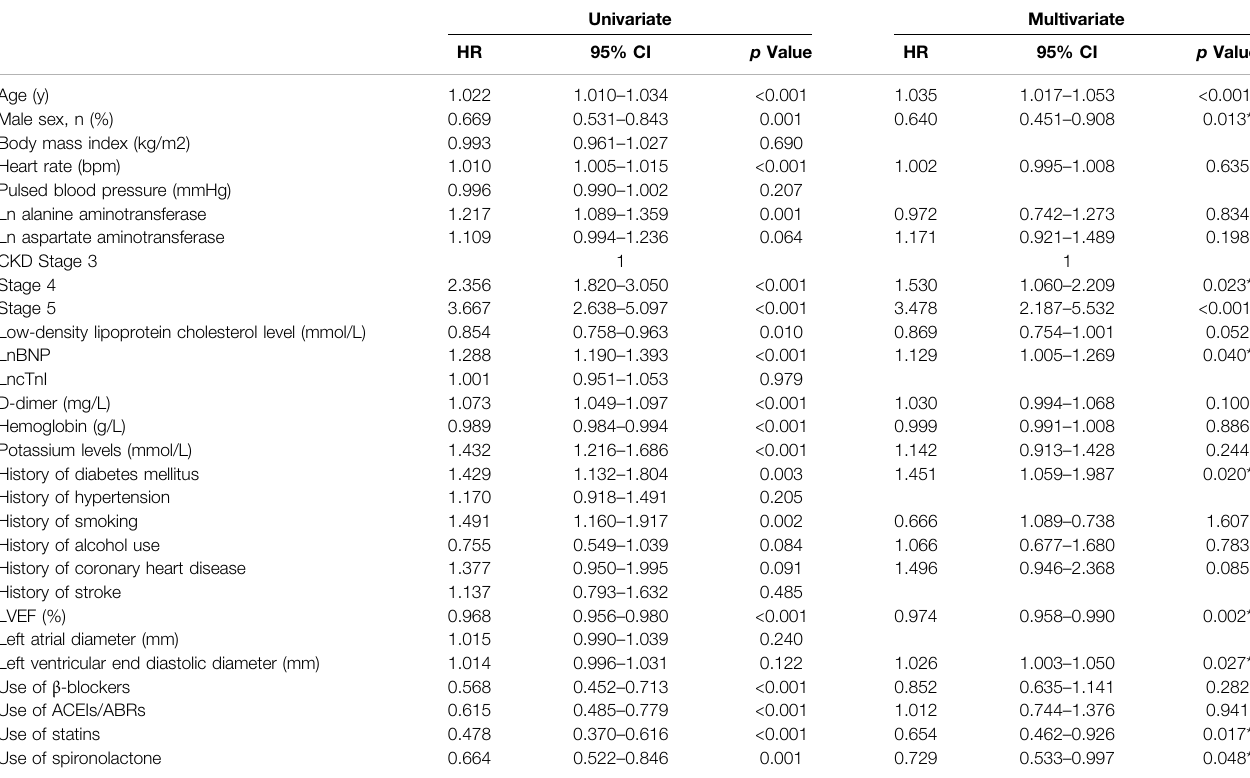
TABLE 4 | Independent predictors for Re-hospitalization in AMI patients with CKD.